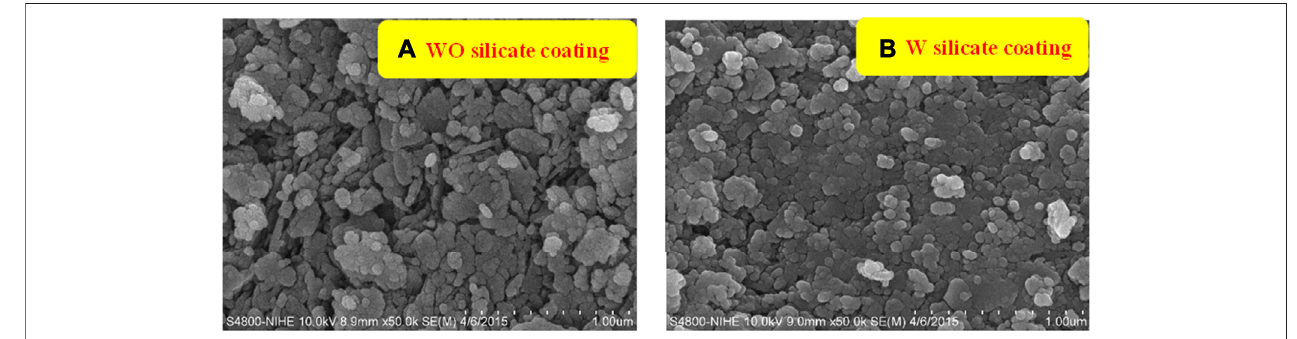
FIGURE 7 | SEM image of WO (A) and W (B) silicate coatings.